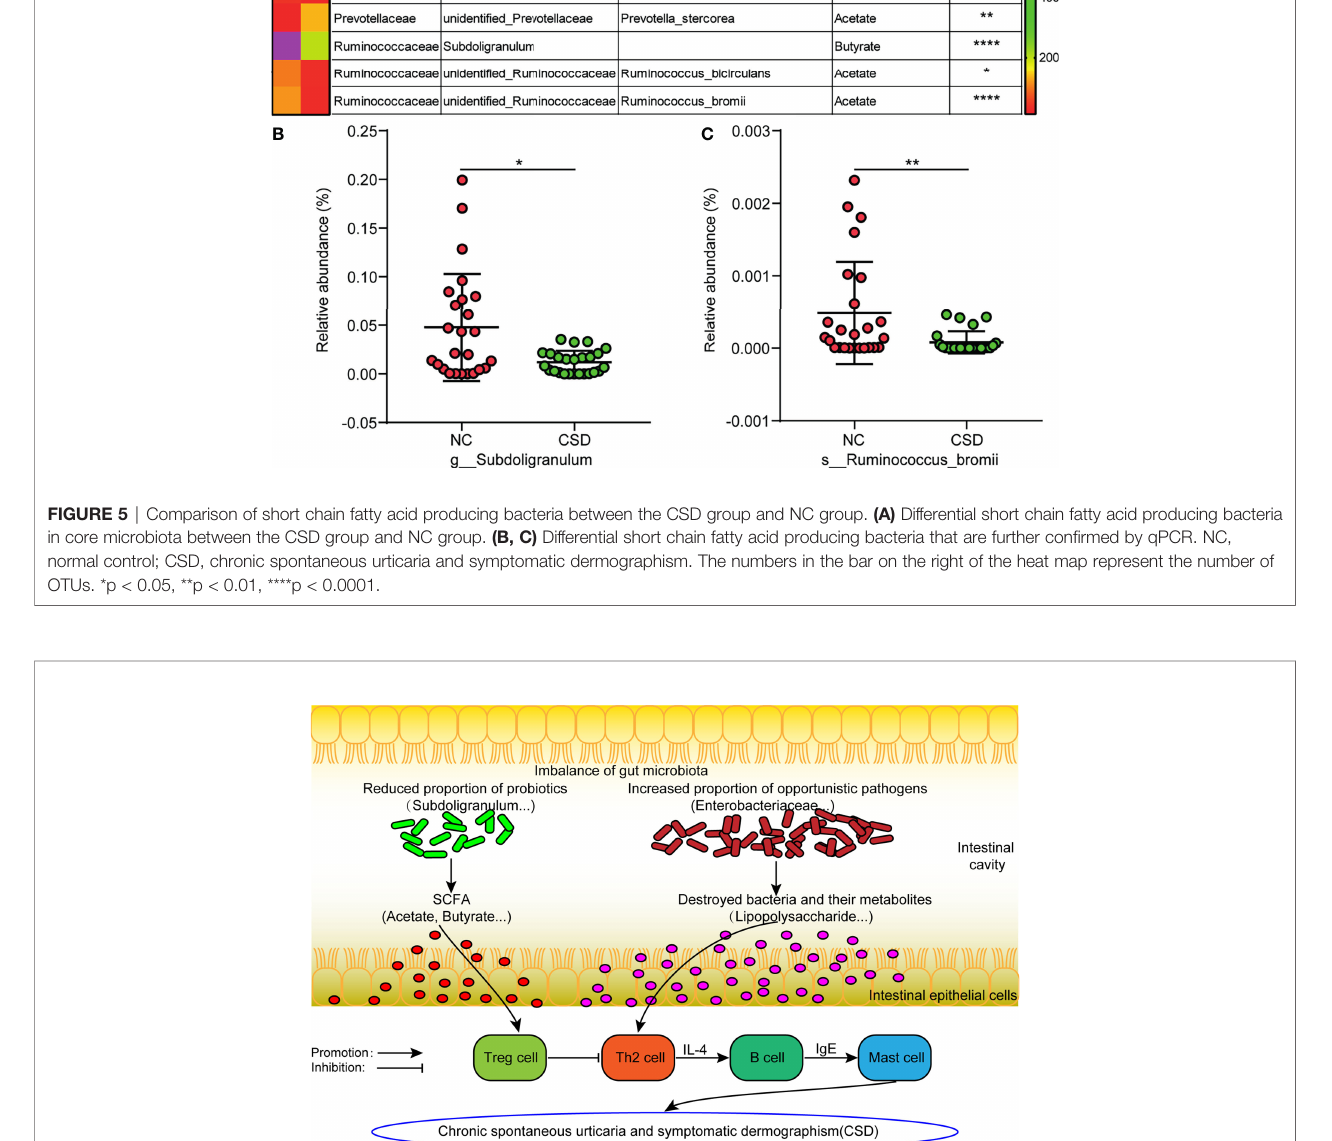
FIGURE 6 | The hypothesis model of dysfunctional gut microbiota involved in the pathogenesis of CSD. SCFA: short chain fatty acid. Treg cell, Regulatory T